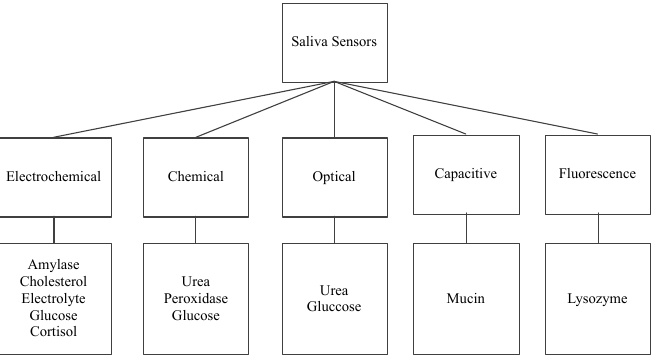
Figure 2. Saliva sensors and their working